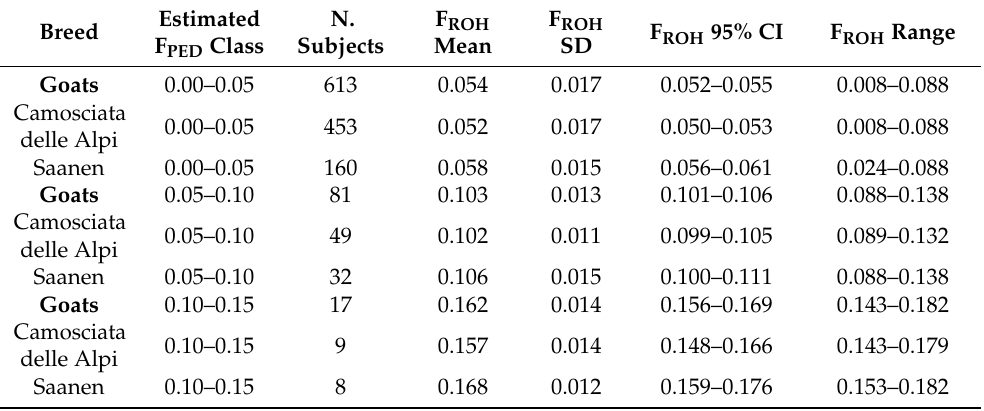
Table 3. Number of goats, F ROH range, mean, standard deviation (SD) and 95% confidence interval (CI) per each class of estimated F PED